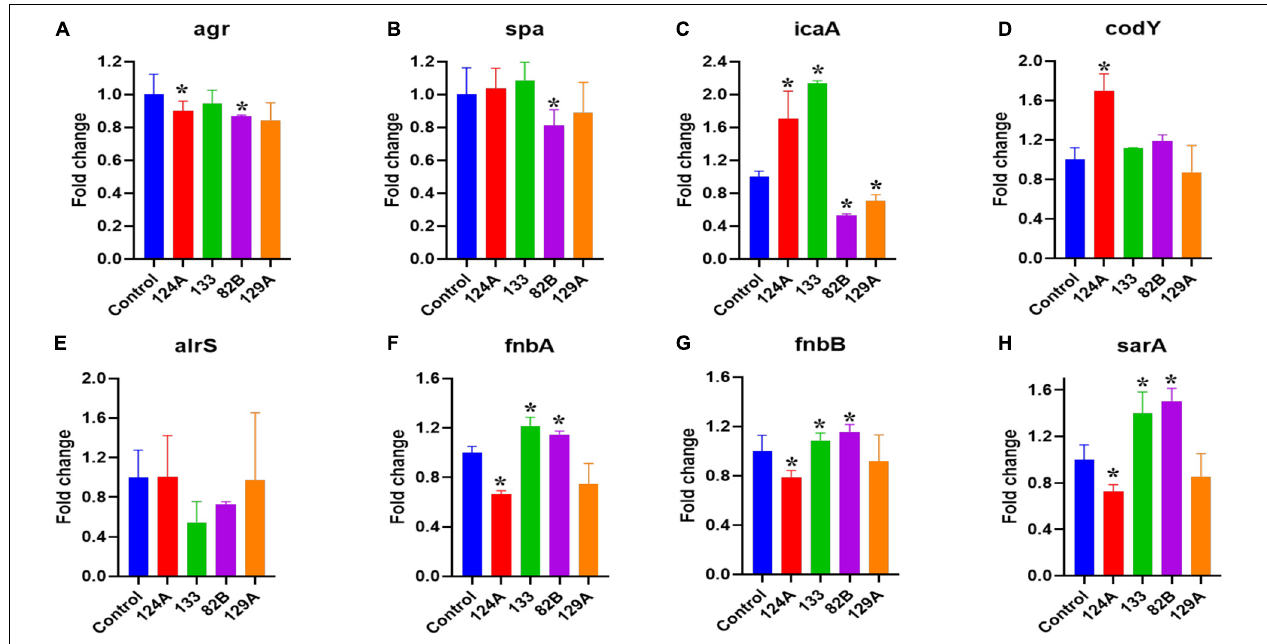
FIGURE 7 | QS genes that contribute to S. aureus virulence were assessed with real-time quantitative evaluation (qPCR) by exposing bacteria to lead compounds (at 4 µ g/ml). (A–H) Major S. aureus virulence genes tested. (*) refers to significant values with p < 0.05 based on a student t -test comparing the compound treated bacterial samples to the control (PBS